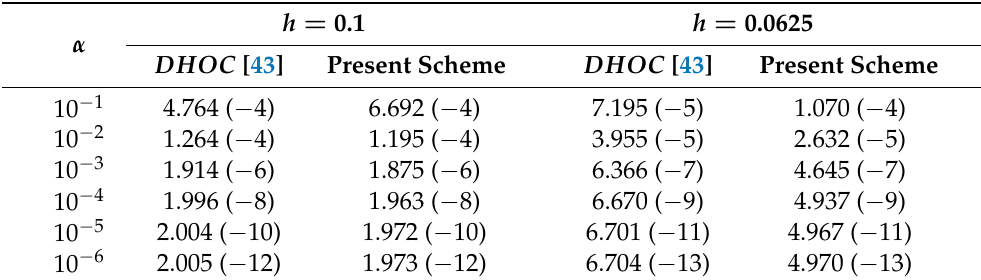
, α = 0.1, T = 2 for different mesh ratio λ = τ 16